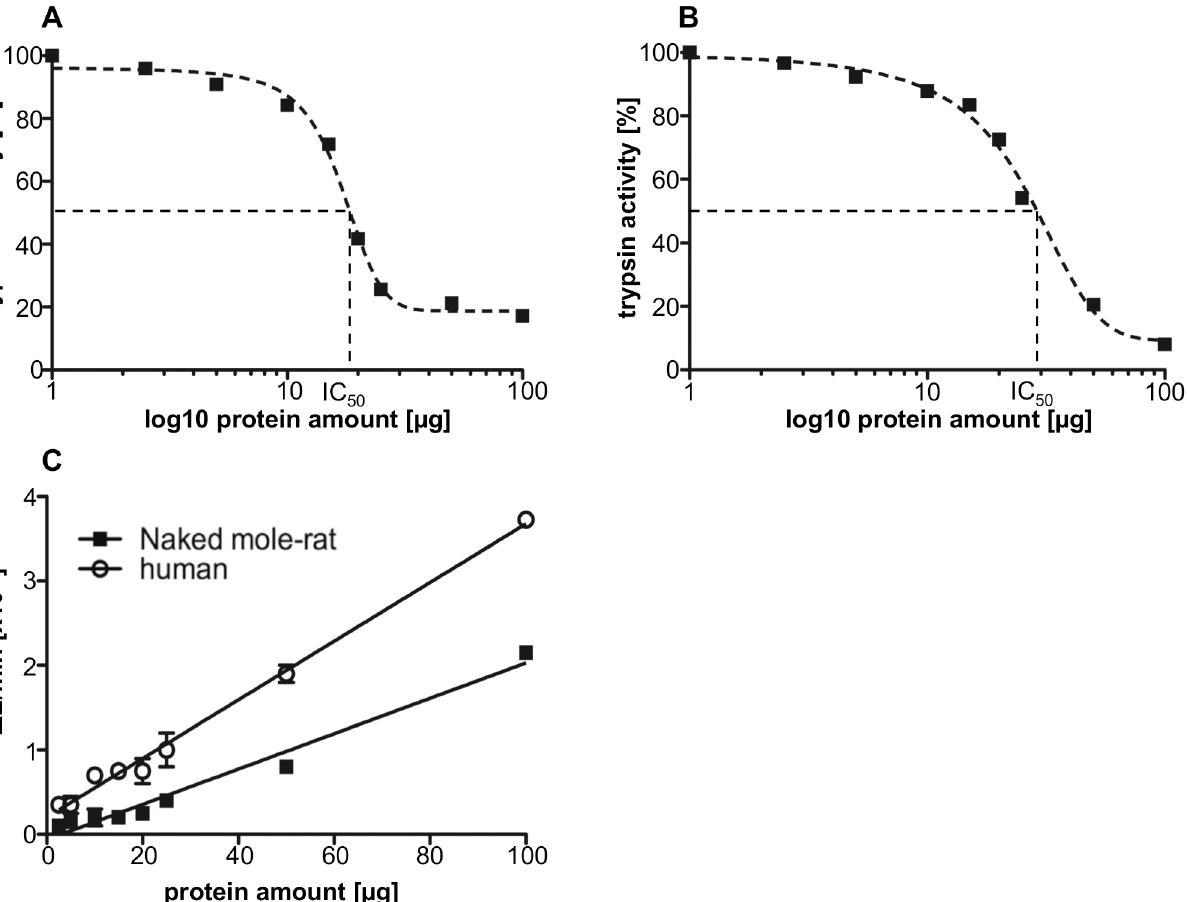
Fig 5. Anti-tryptic and proteolytic activity of NMR and human plasma. The inactivation of 0.05 μ g trypsin was titrated with increasing amounts of human (A) or NMR (B) plasma corresponding to 1 – 100 μ g protein and measured by the conversion of BAPNA to p-nitroaniline at 405 nm. The intrinsic tryptic activity of NMR and human plasma was determined by measuring the conversion of BAPNA to p-nitroaniline induced by 1 – 100 μ g plasma protein (C). ( * — p < 0.05)